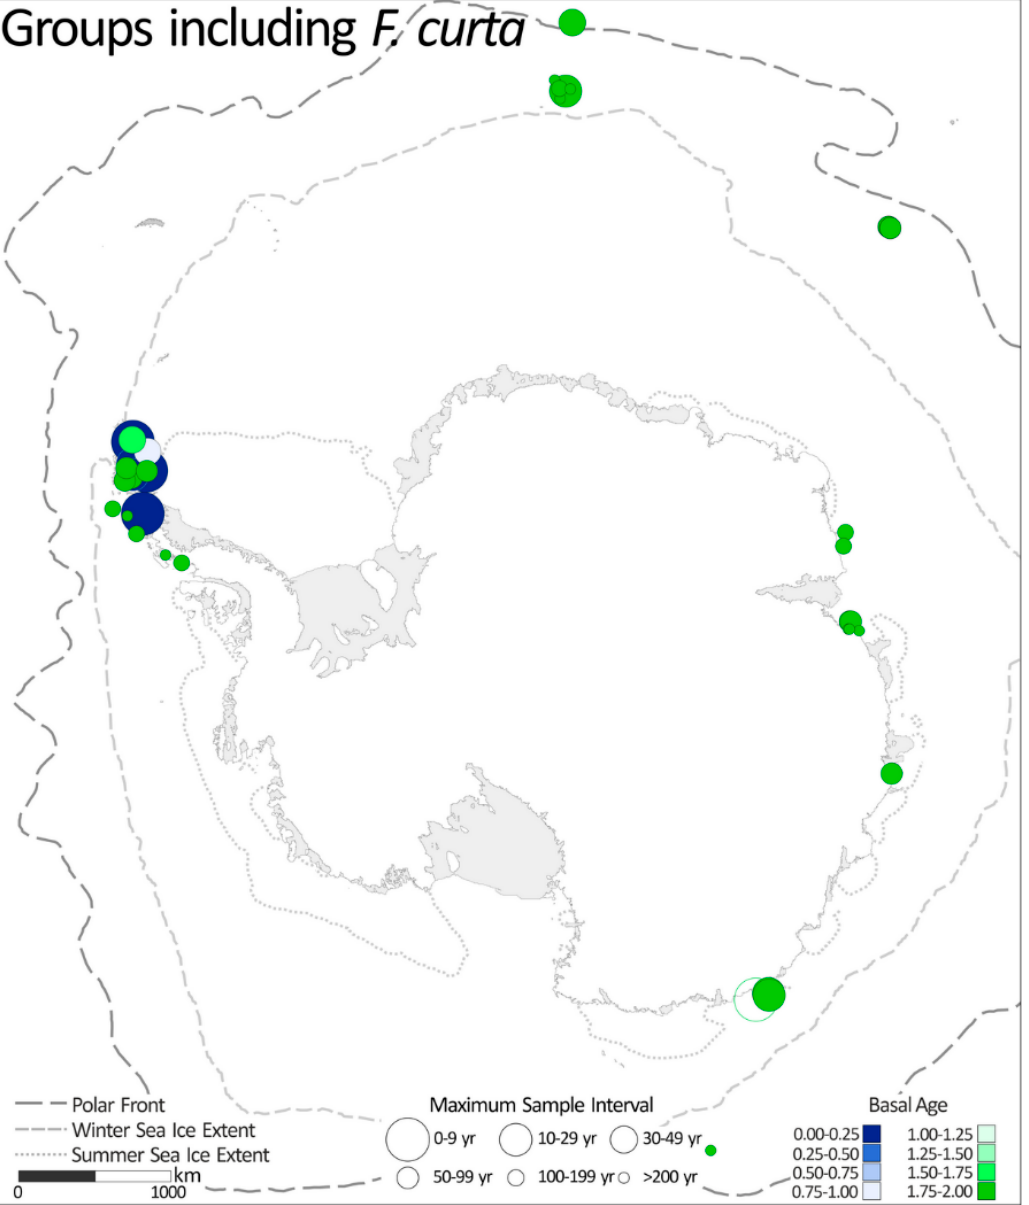
Figure 6. Map showing cores sites where groups of taxa including F. curta are used to reconstruct sea ice conditions. The symbol size reflects the resolution of the record and the color of the symbol indicates the basal age of the record between 0 and 2 ka BP. The hollow circle symbols are used for discrete and/or discontinuous records from laminated sediments to illustrate the resolution only.